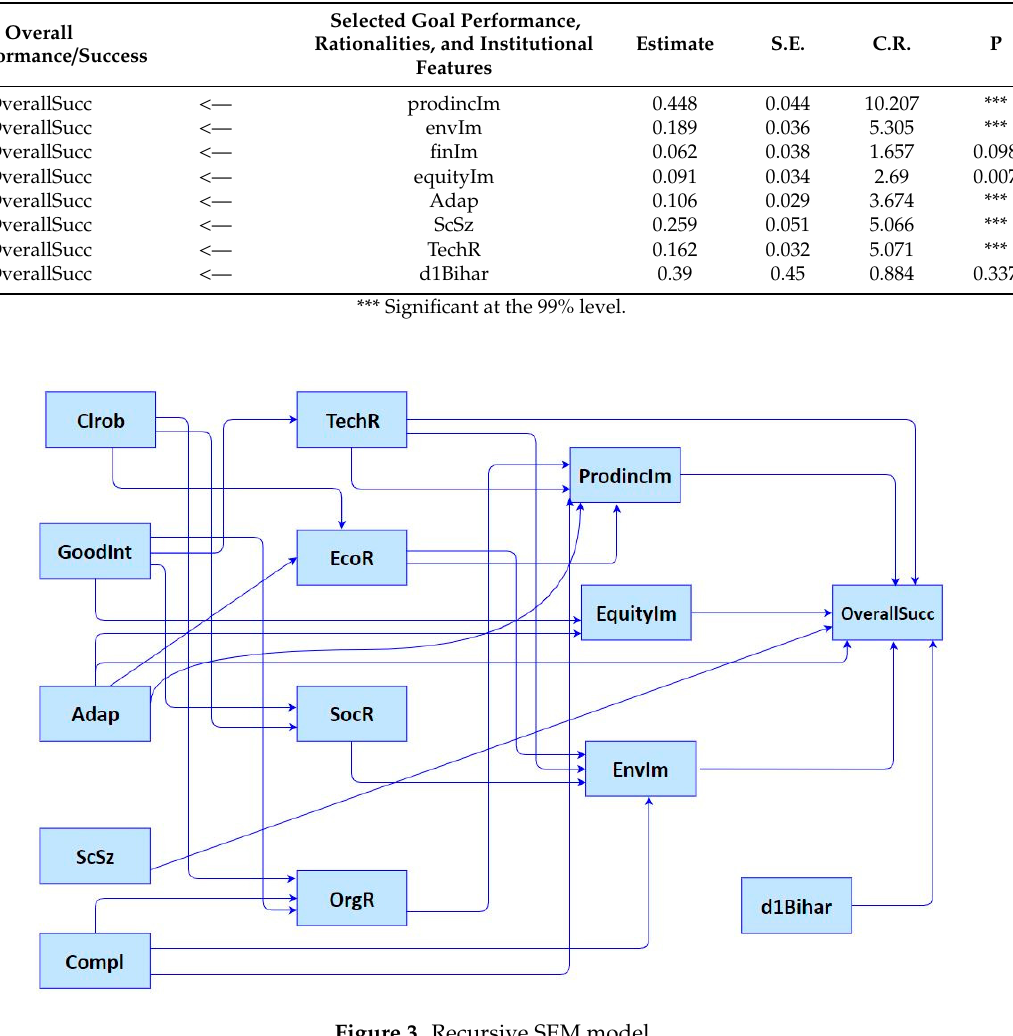
Figure 3. Recursive SEM model.